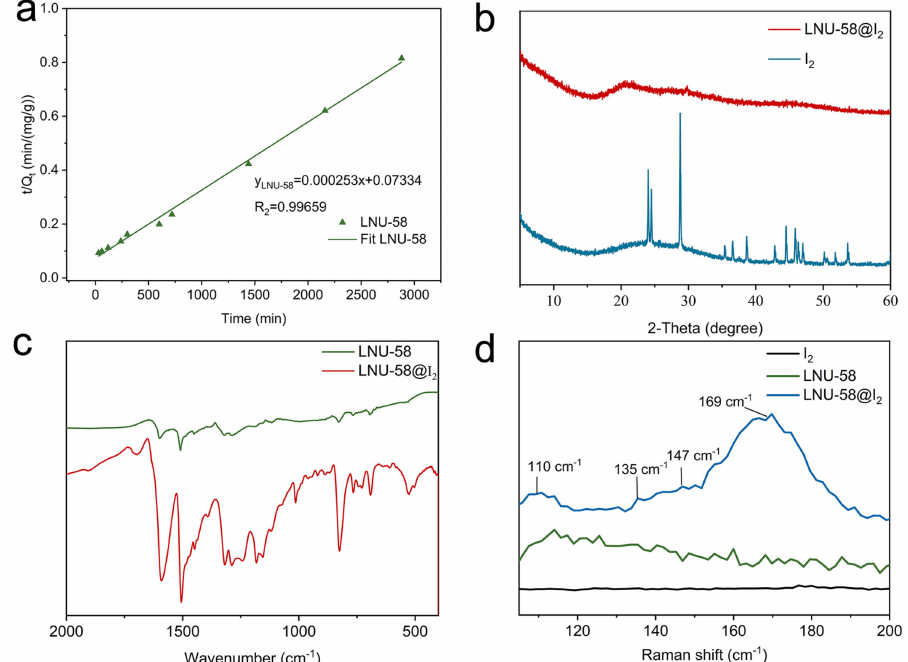
Figure 5. ( a ) Pseudo-second-order model plot for the iodine vapor uptake into LNU-58; ( b ) PXRD patterns of I 2 and LNU-58@I 2 ; ( c ) FT-IR spectra of LNU-58 and LNU-58@I 2 ; ( d ) Raman spectra of I 2 , LNU-58, and LNU-58@I 2